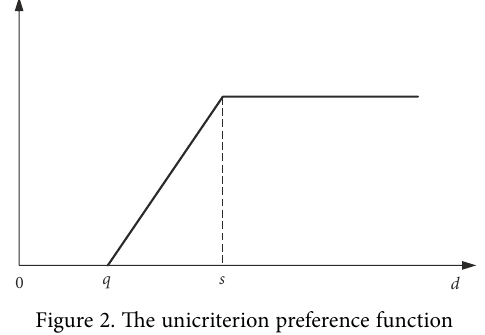
Figure 2. The unicriterion preference